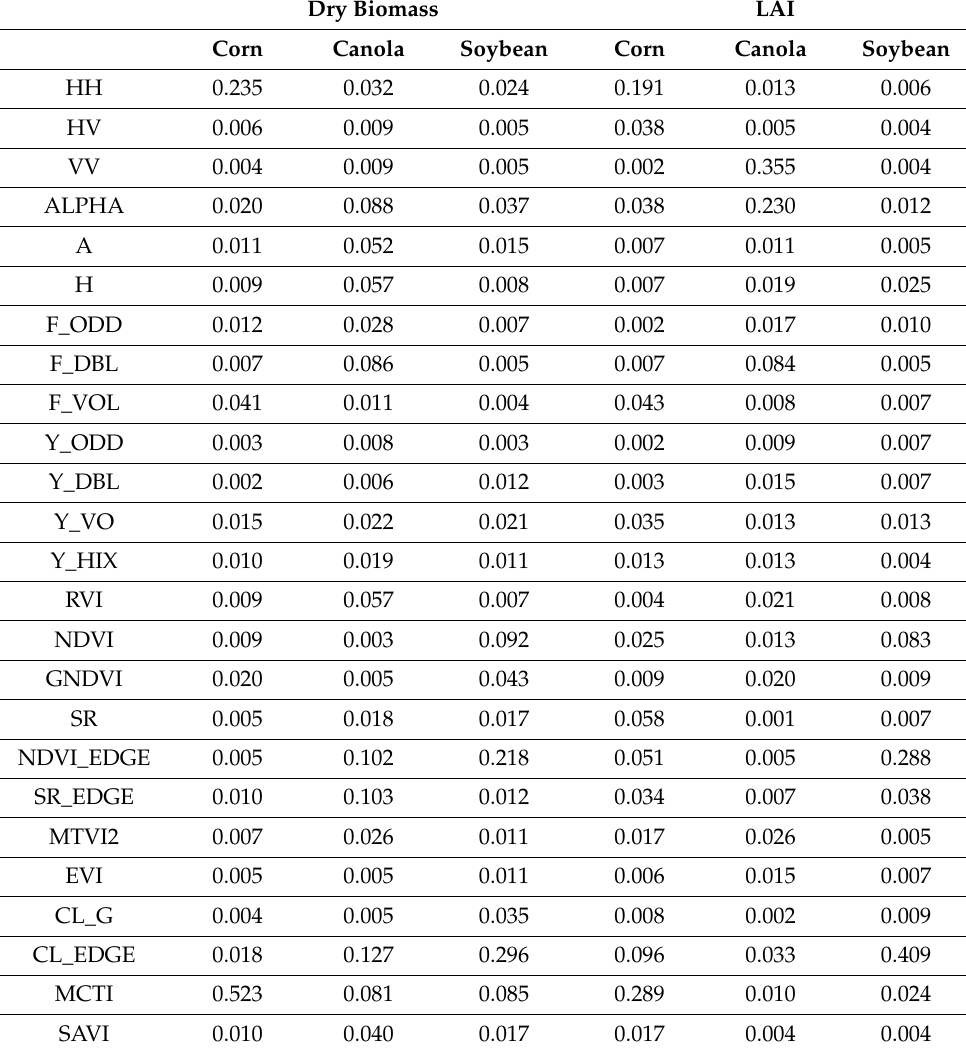
Table 6. RF feature importance results.